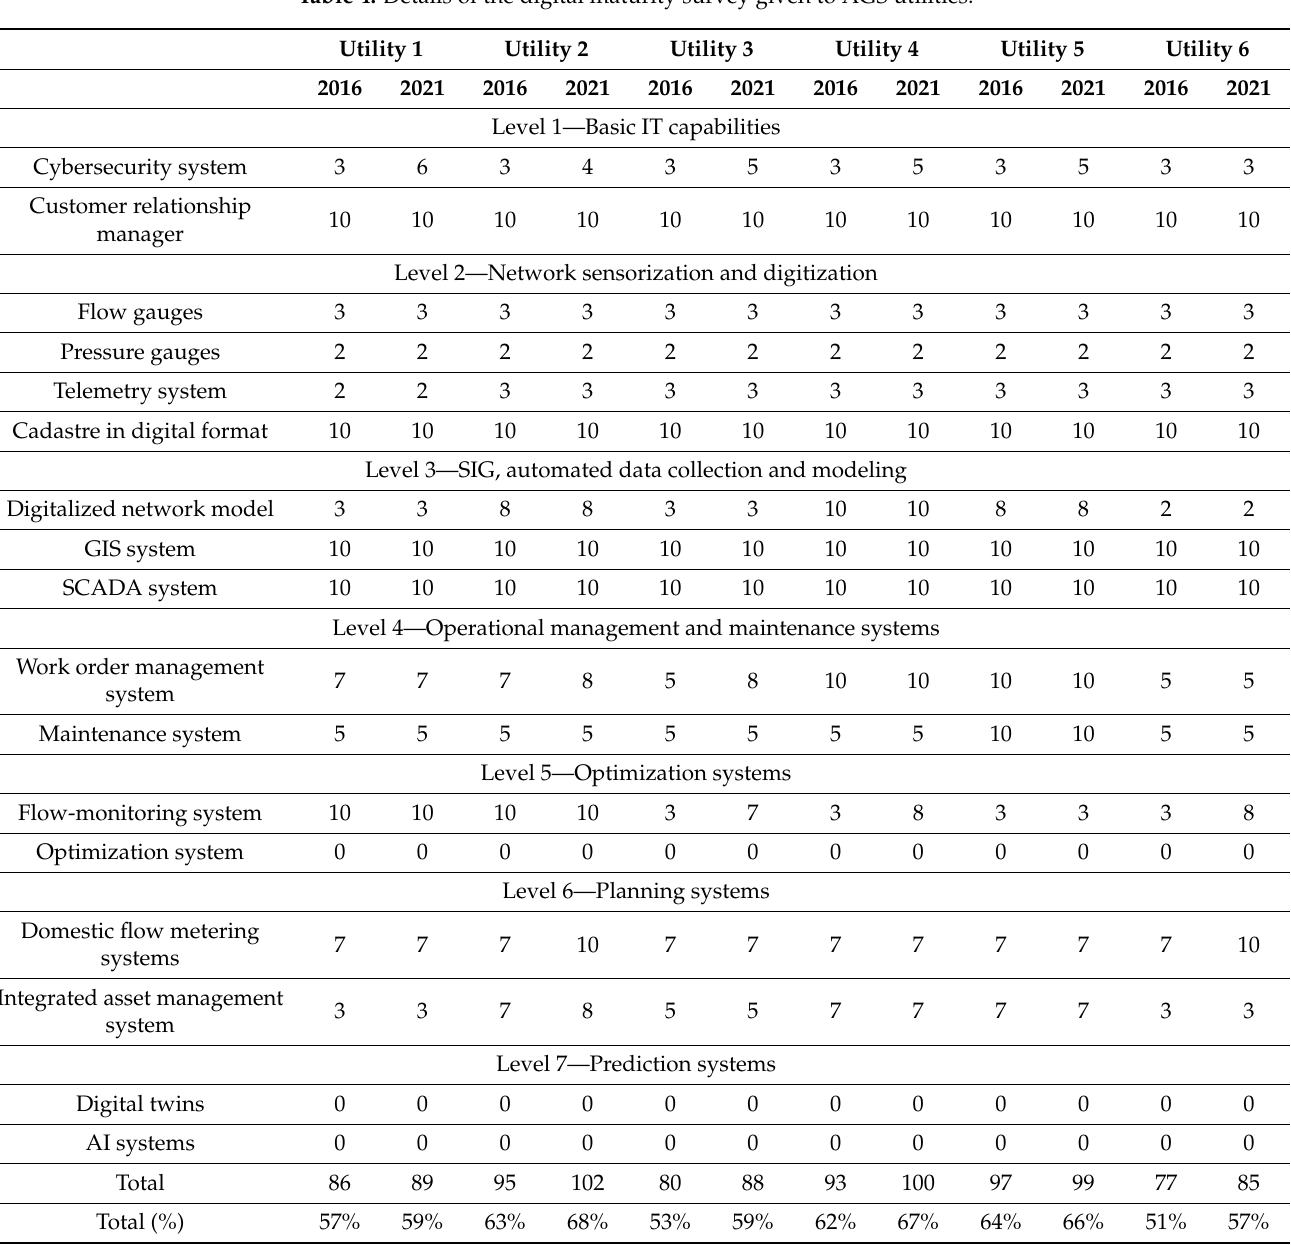
Table 4. Details of the digital maturity survey given to AGS utilities.